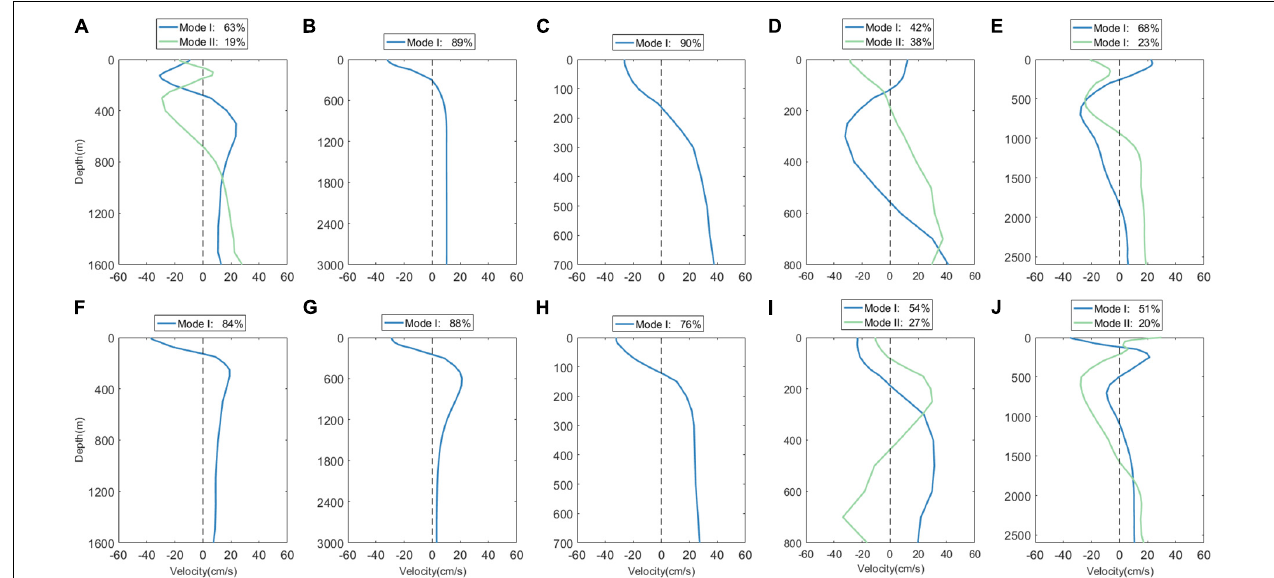
FIGURE 12 | Empirical orthogonal function (EOF) modes of eastward velocity of overtides at (A–E) sites A to E and corresponding results of (F–J) the northward velocity.